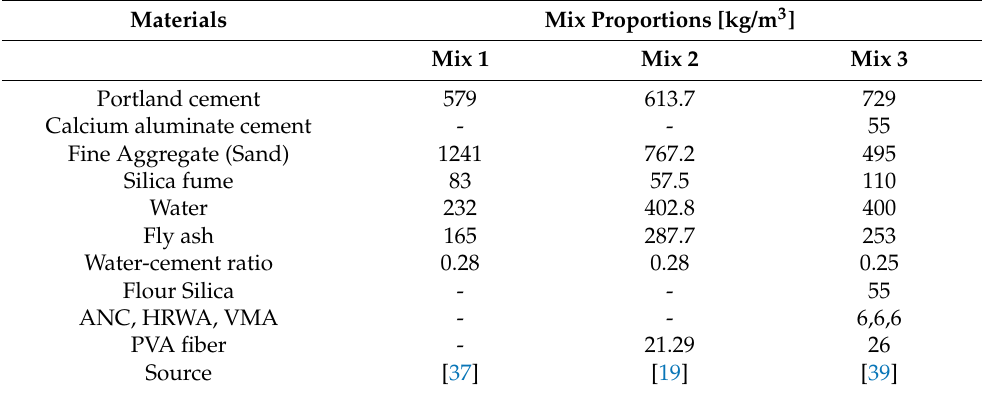
Figure 2. Building information: ( a ) (i) Building plan; ( a ) (ii) Zoning layout; ( b ) (i) Building Elevation; ( b ) (ii) Sectional view; ( b ) (iii) Walling layout. Table 1. Mix Designs of the Adopted 3DPC